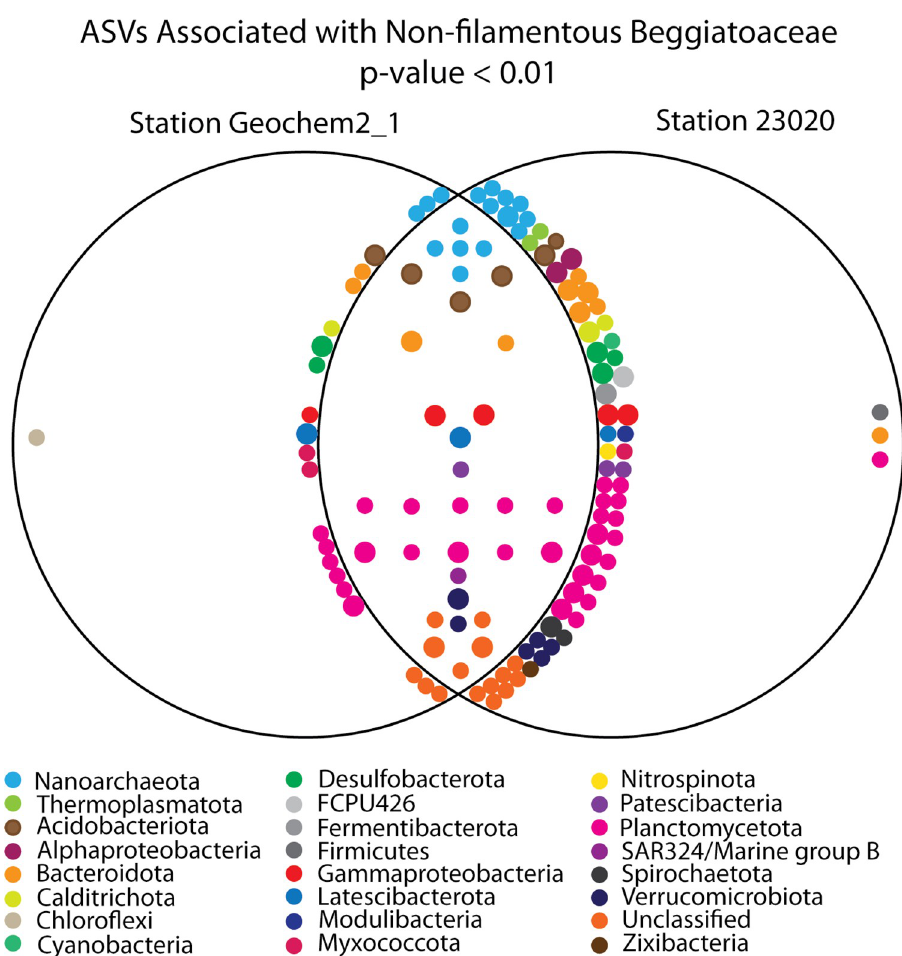
Fig 6. Modified Venn diagram of 123 ASVs detected by DESeq2 as having a statistically significant association with non-filamentous Beggiatoaceae hosts from Marine Station Geochem2_1 and Marine Station 23020. ASVs represented in both circles were found to have a significant association with the hosts from both stations. ASVs neighboring the overlapping circles, we determined likely also were significantly enriched the other station but a single low representative inhibited detection via DESeq2. ASVs represented by large circles appeared to also be enriched in the sample from shallow station 23002.